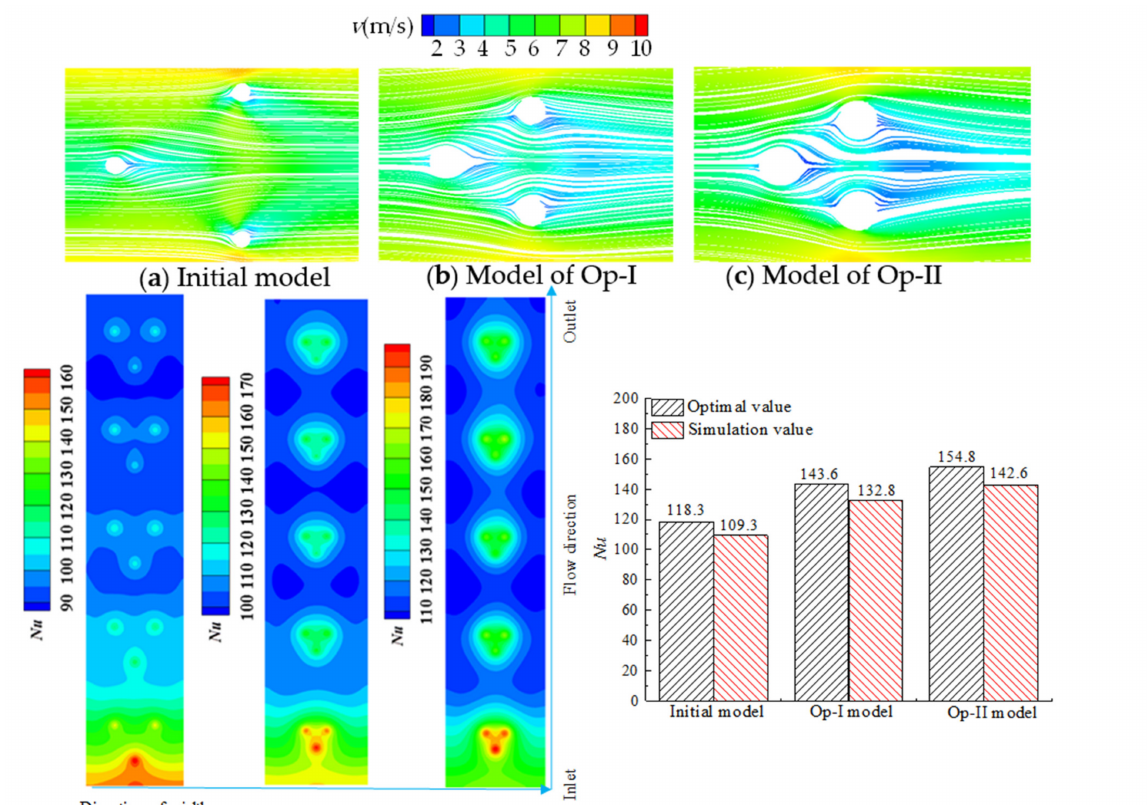
Figure 12. Numerical simulation results of